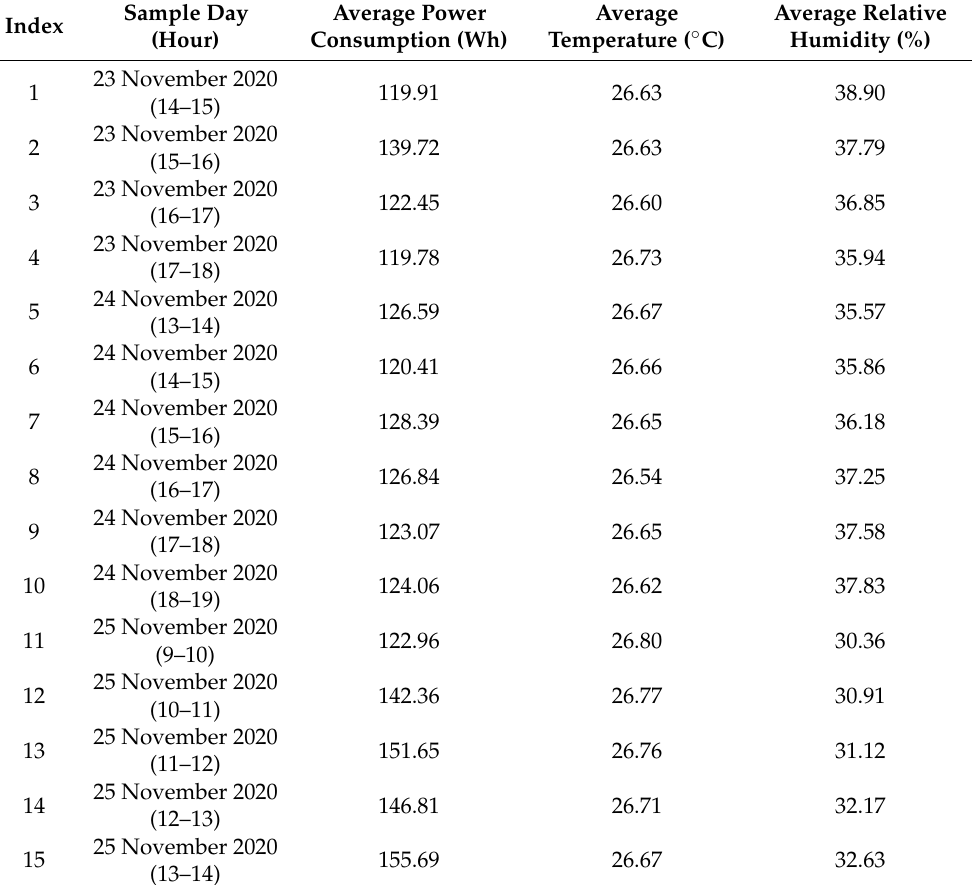
Table 6. Power consumption, temperature. and humidity of the HVAC equipment with the proposed control